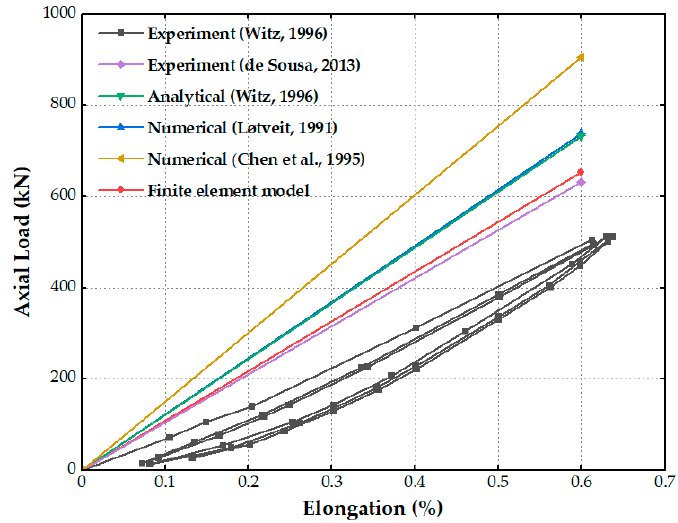
Figure 6. Axial tension–elongation relations observed by different researchers [37–40].